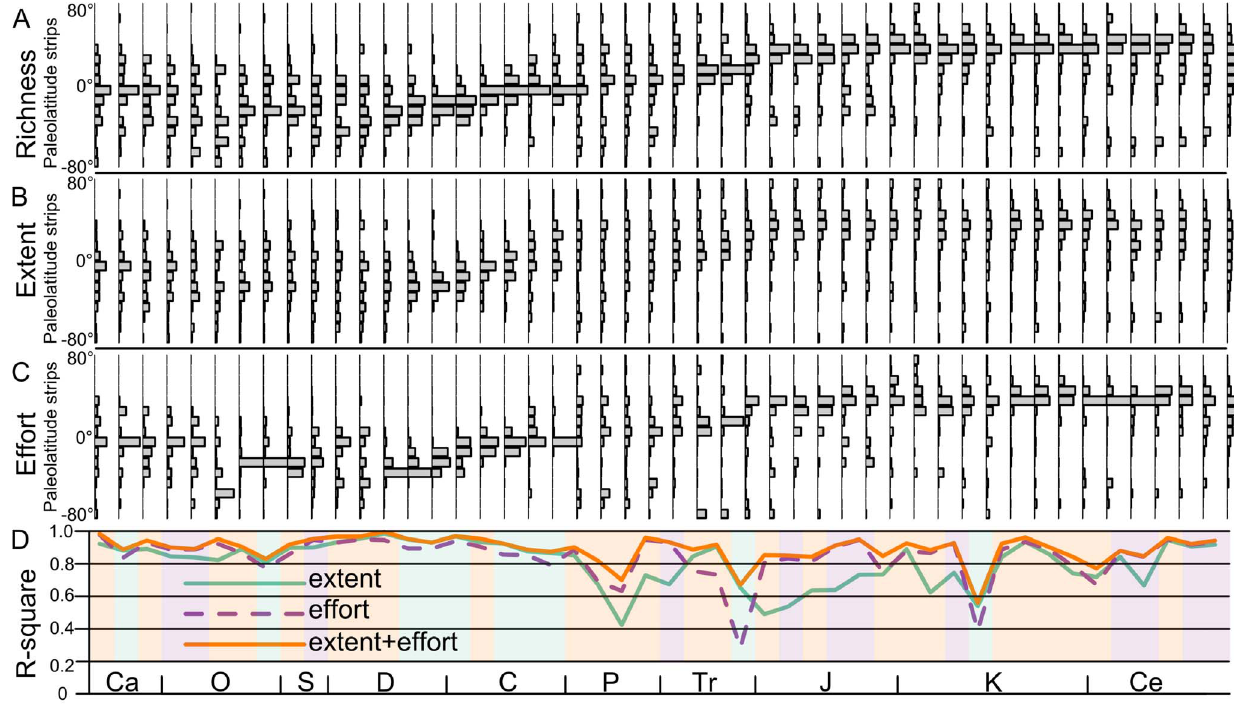
Figure 2. Patterns of richness and sampling proxies through the Phanerozoic. A) Distribution of genus richness across paleolatitude strips. B) Distribution of total equal area grid cells with at least one fossil locality recorded in the PaleoDB across paleolatitude strips. C) Distribution of faunal lists with collection IDs in the PaleoDB across paleolatitude strips. D) The percentage variation of richness in each paleolatitude strips explained by geographic coverage and sampling intensity in each of those paleolatitude strips. Note that the sampling proxies are not rendundant; parts of the Phanerozoic lack geographic coverage but have high sampling intensity and vice versa. Each interval is shaded by the color of the model with the lowest AIC score.